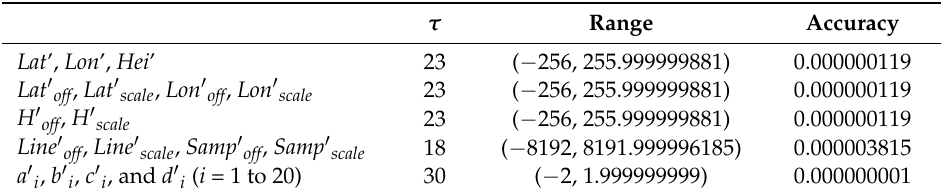
Table 5. Scale factors for parameters of First Area.